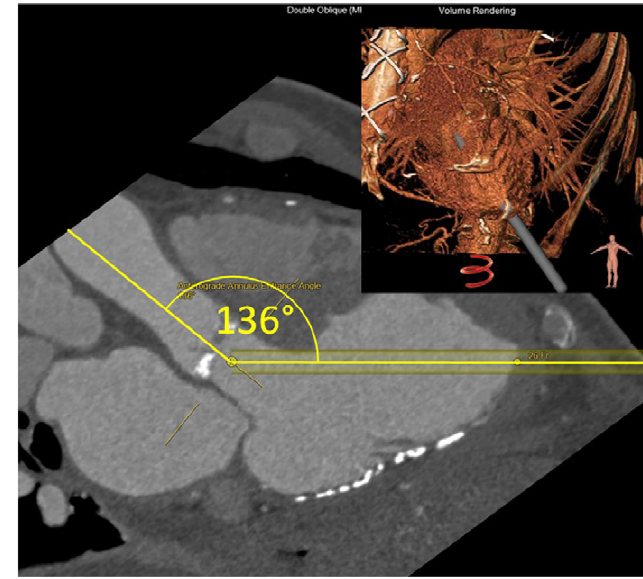
Figure. 3 Angle between LVOT and transapical entry vector through intercostal space.